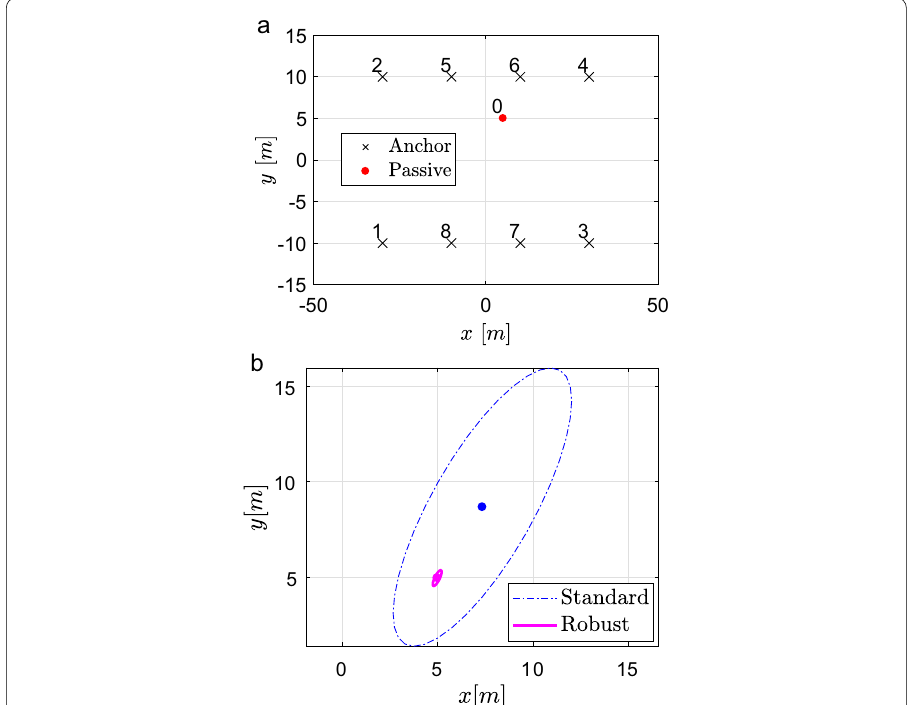
Fig. 1 Self-localization of the passive receiving node ( ◦ ) in a at location (5, 5) using eight anchor nodes ( × ) and time-difference-of-arrival ( T doa ). The resolution of the interarrival times is on the order of 3ns and n = 100 observations are used. Here ǫ = 15% of the data is corrupted by non-line-of-sight ( N los ) outliers. In b , and denote the mean position estimated using the standard nonlinear least-squares method (8) and the proposed robust method. The ellipses illustrate the dispersion of location estimates with approximately 99.9% coverage for the standard (dotted) and robust (solid)